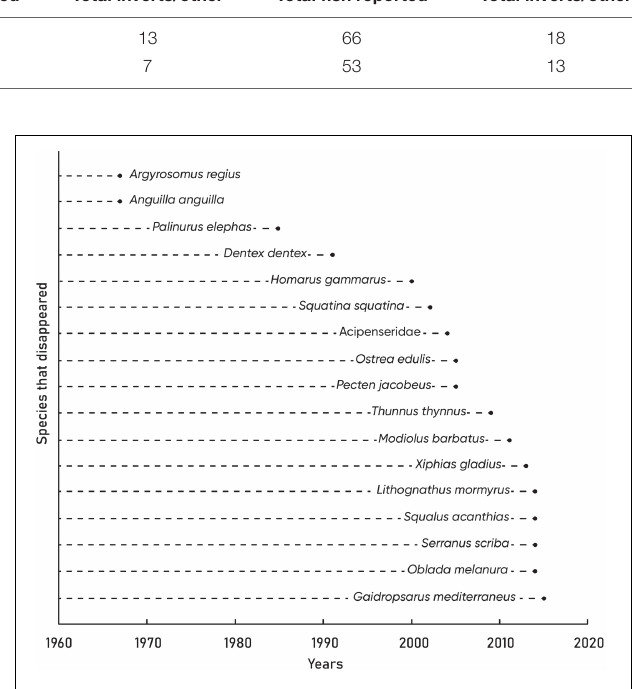
FIGURE 2 | A timeline of marine extirpations from Turkish waters in the Black Sea.